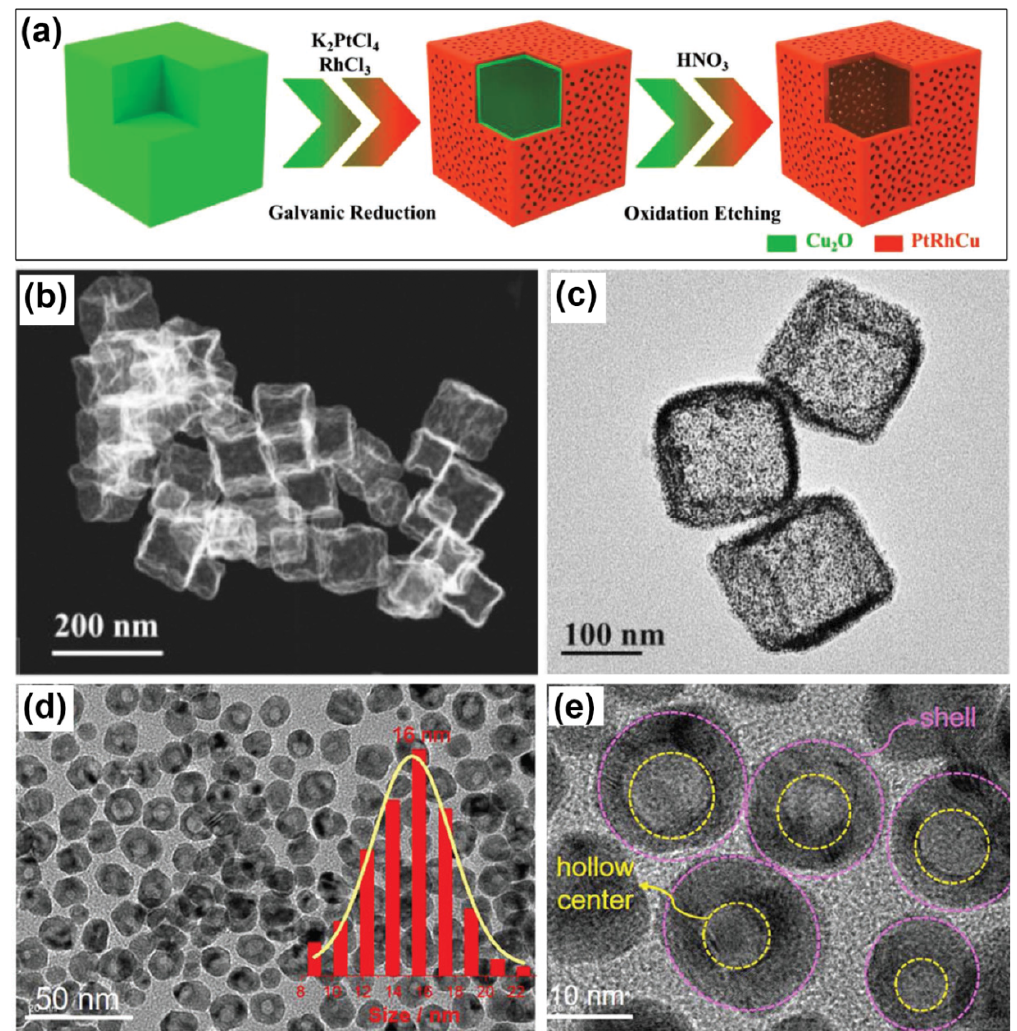
Figure 7. ( a ) Schematic diagram of the preparation process for PtRhCu nanoboxes. ( b ) HAADF-STEM image and ( c ) TEM image of PtRhCu trimetallic nanoboxes. Reproduced with permission from [98] . Copyright 2018, WILEY-VCH. ( d , e ) TEM images of PdRh nanobowls. The inset in (d) refers to the size distribution histogram. Reproduced with permission from [103] . Copyright 2019, The Royal Society of Chemistry.